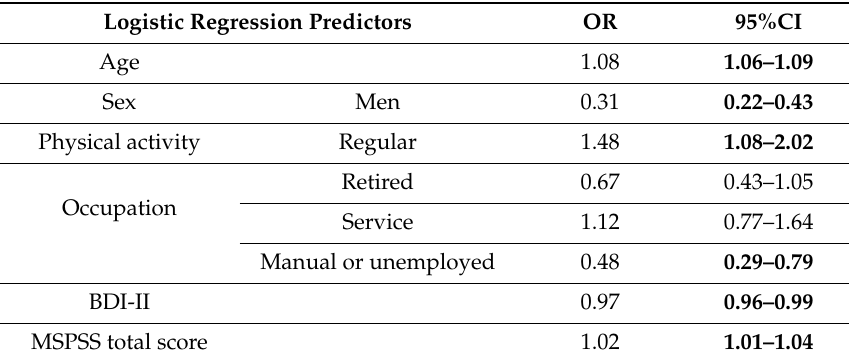
Table 4. Logistic